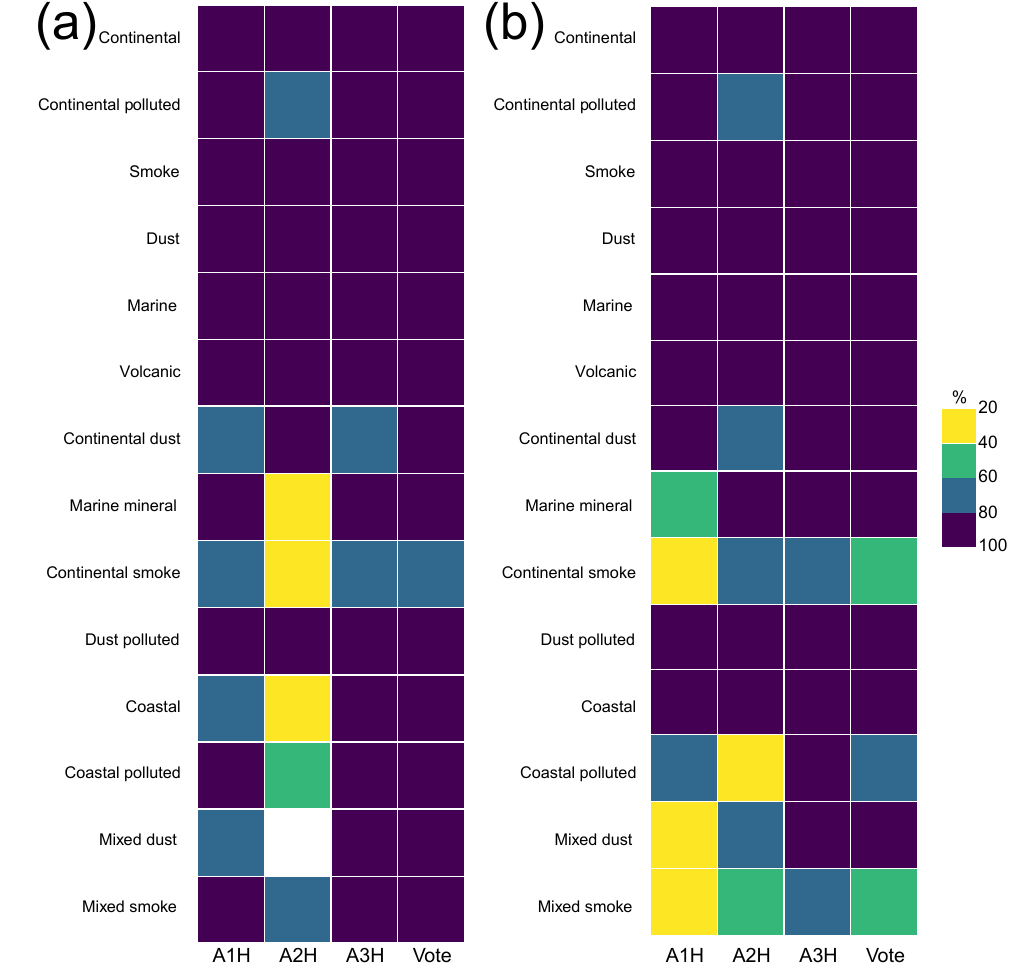
Figure 7. Performances of ANNs for (a) high-resolution typing and (b) low-resolution typing for each ANN (i.e. A1H, A2H, A3H) and the combine results (vote) of the three ANNs. The intervals of ANN confidence levels are shaded according to the